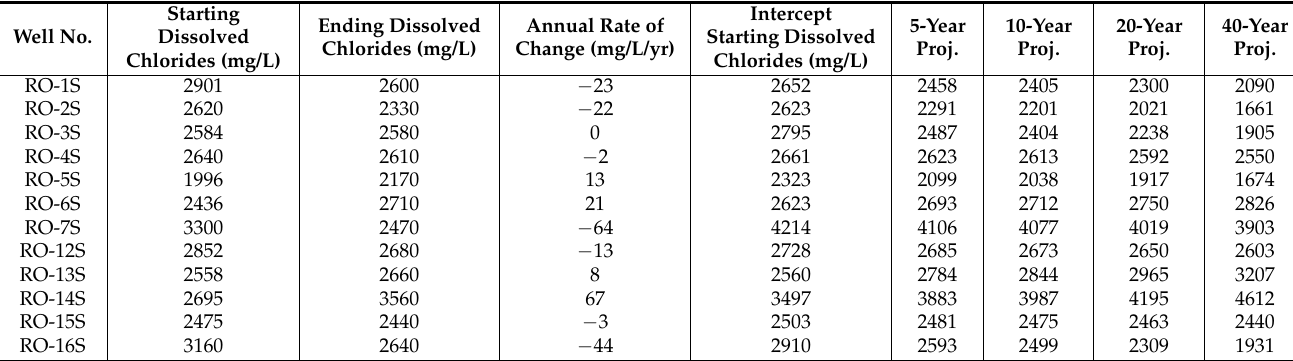
Table 3. Hawthorn Aquifer Zone 1 production wells annual rate of change in dissolved chloride concentrations with 5, 10, 20, and 40-year projections. Well